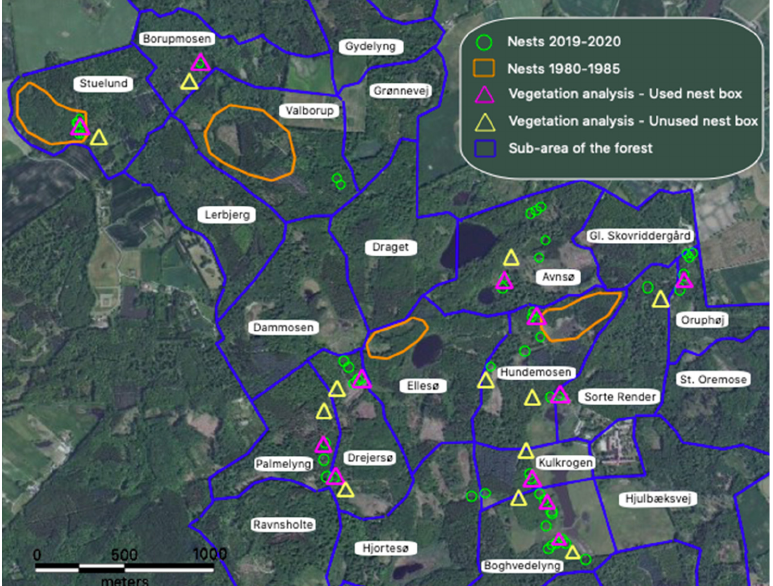
Figure 1. Study area in the Bidstrup forests, where blue lines indicate sub-areas of the forest. Green circles indicate locations of nests from 2019 to 2020. Orange linings indicate the locations of nests from 1980 to 1985, as no coordinates were available. Pink triangles indicate locations of vegetation analysis around used nest boxes, while yellow triangles indicate locations of vegetation analysis around unused nest boxes.